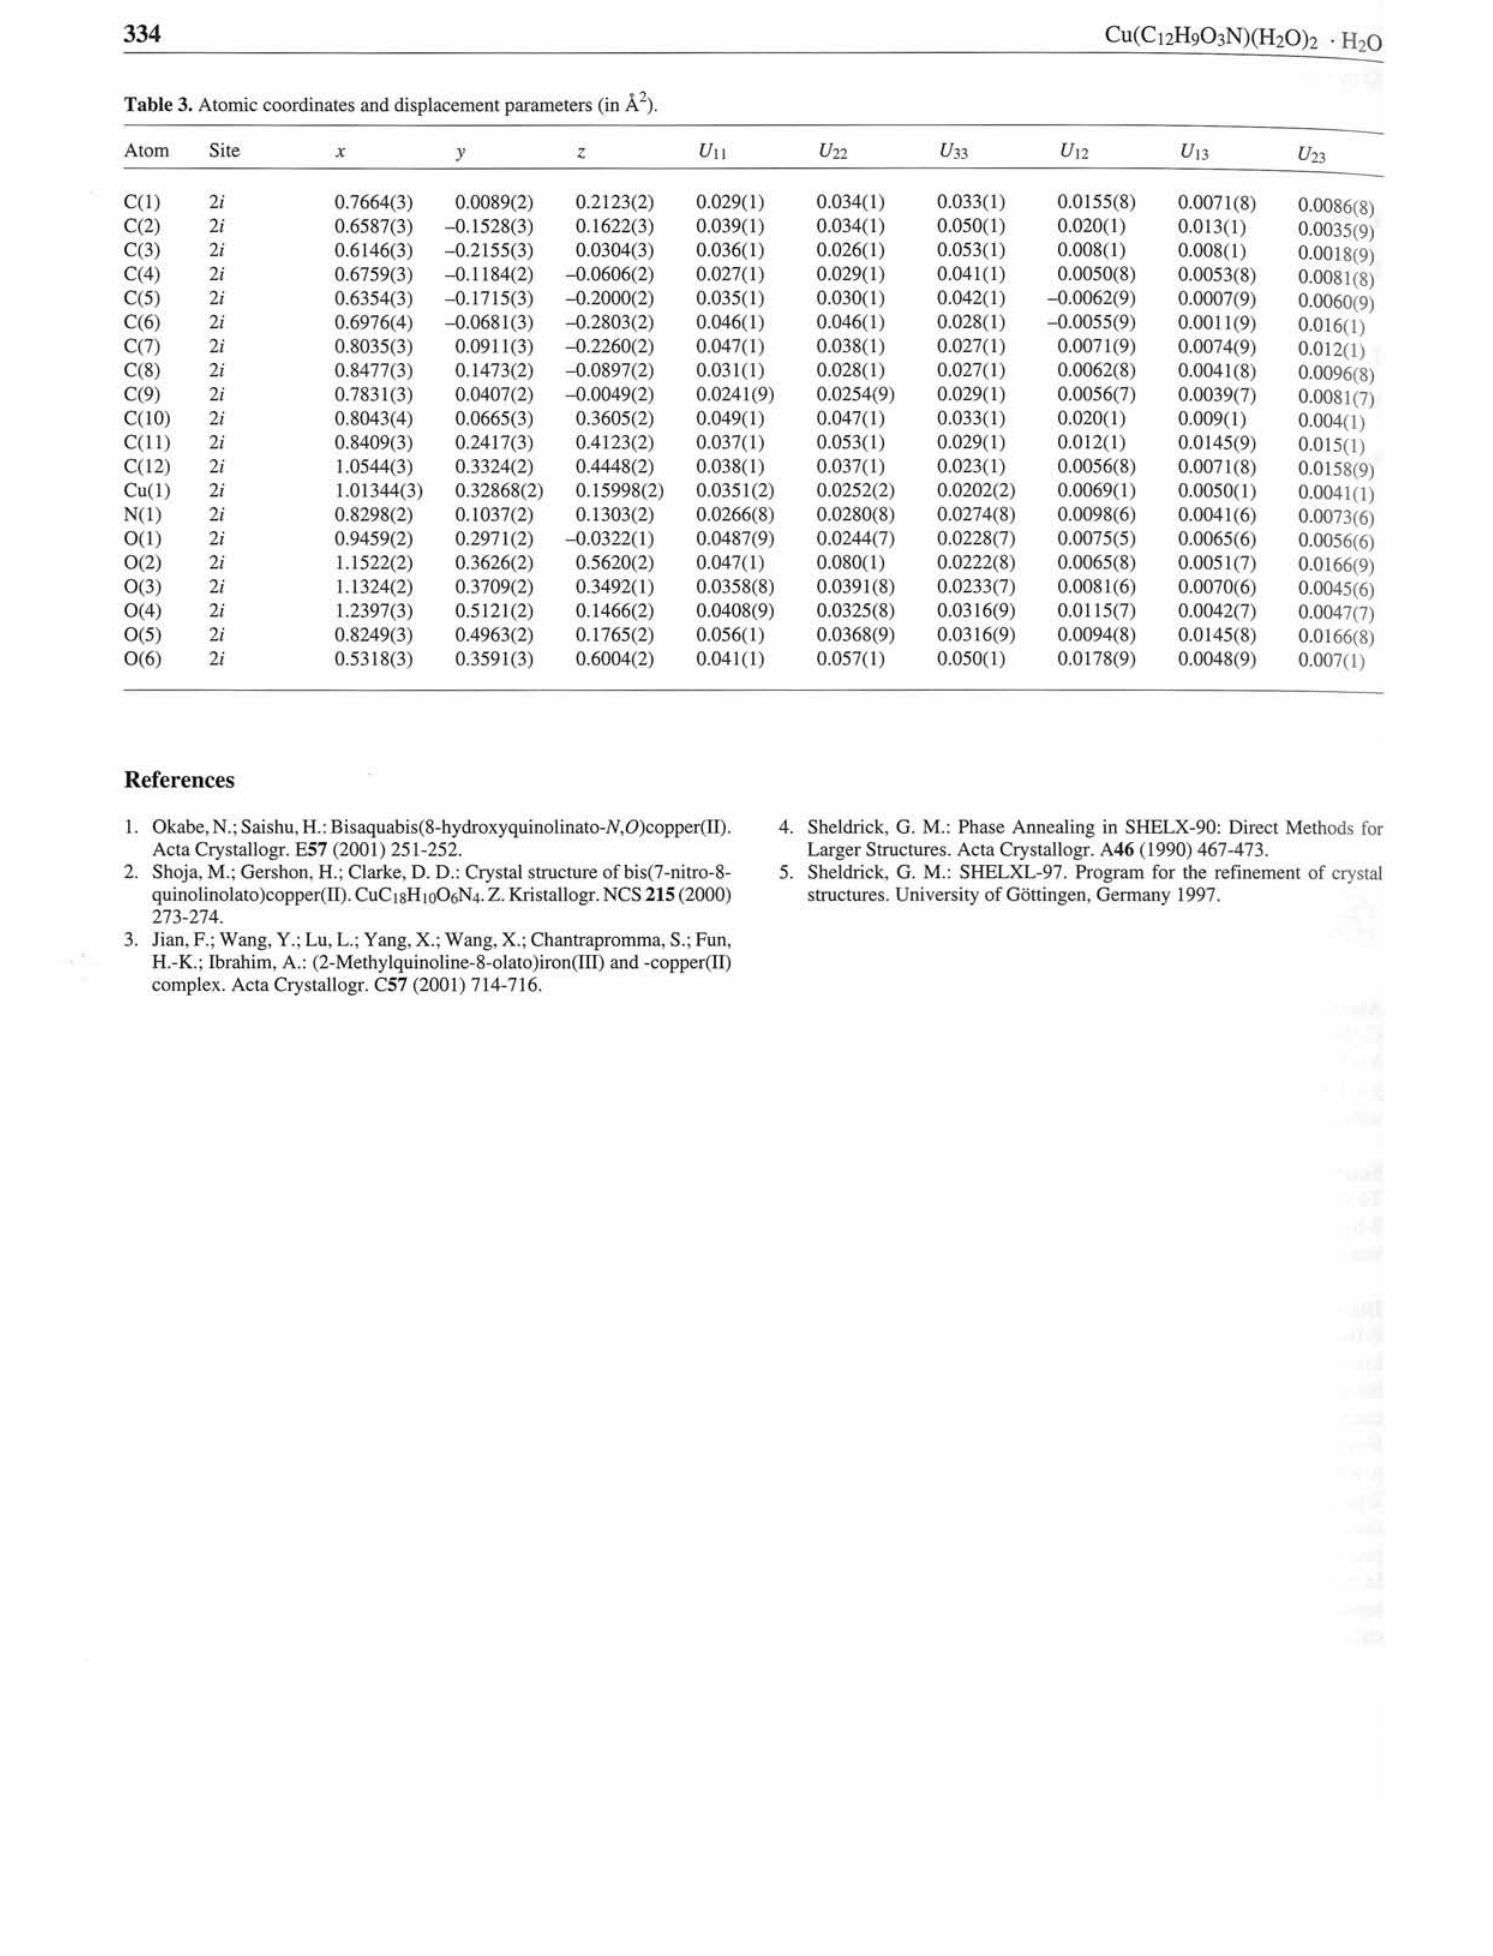
Table 3. Atomic coordinates and displacement parameters (in Â 2